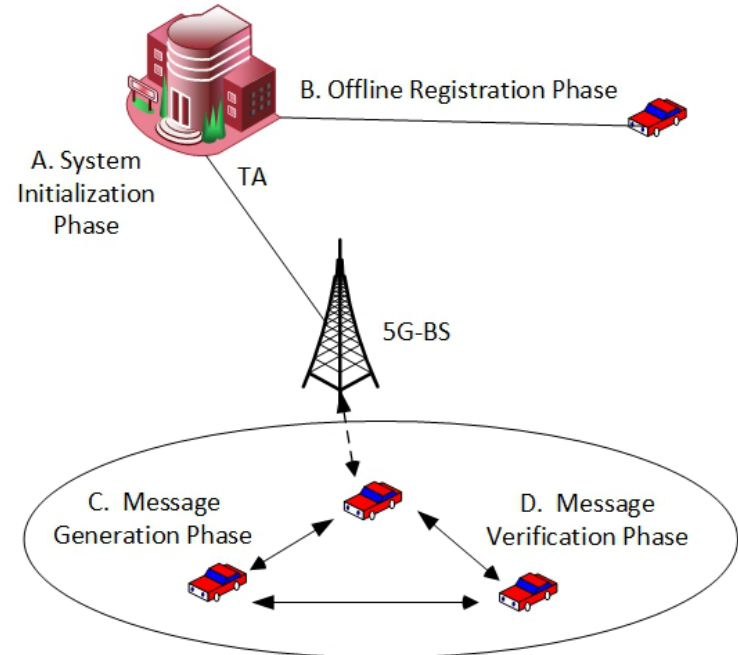
Figure 2. The Proposed CM-CPPA Scheme